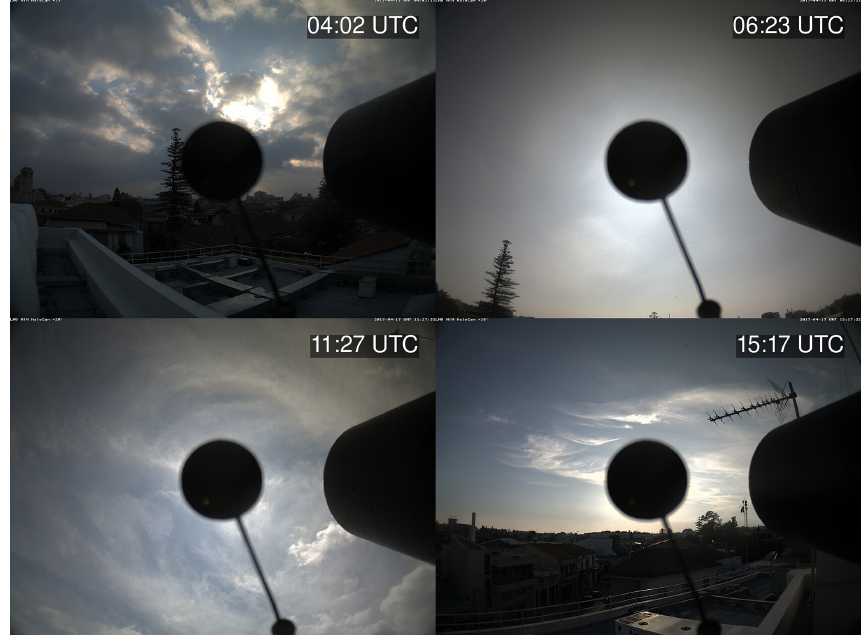
Figure 11. HaloCam images for 17 April 2017. The convective clouds in the early morning and afternoon are visible. The persisting cirrus clouds towards the evening can be